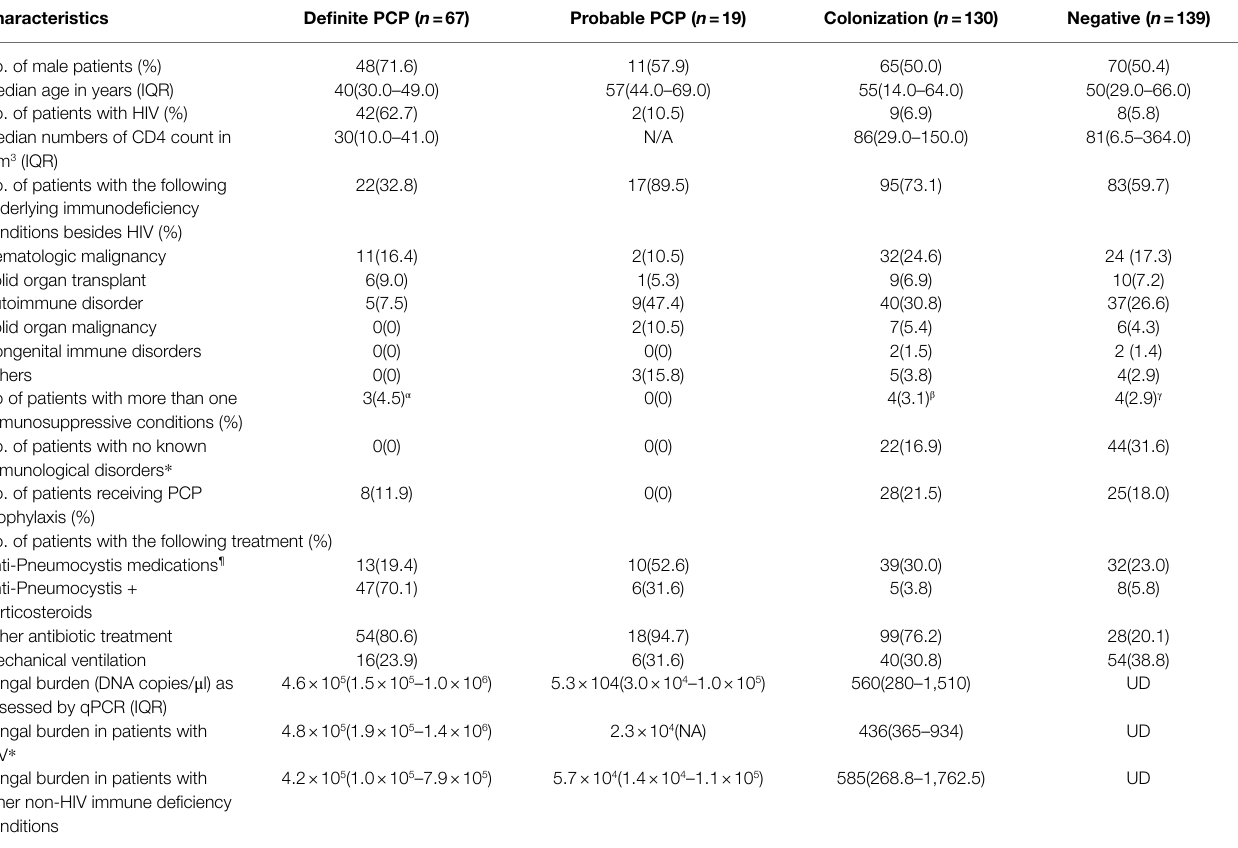
TABLE 2 | Patient demographic data and clinical characteristics compared among the Pneumocystis infection-based classification ( N = 355). Characteristics